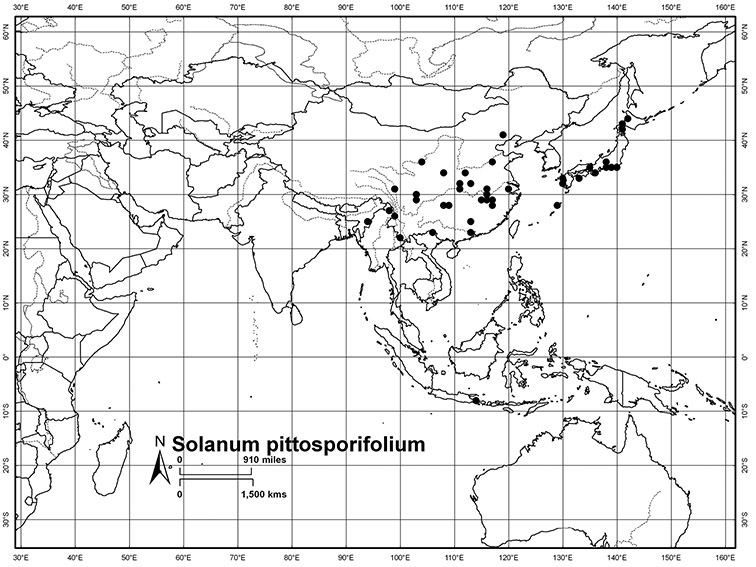
Distribution of Solanumpittosporifolium Hemsl.